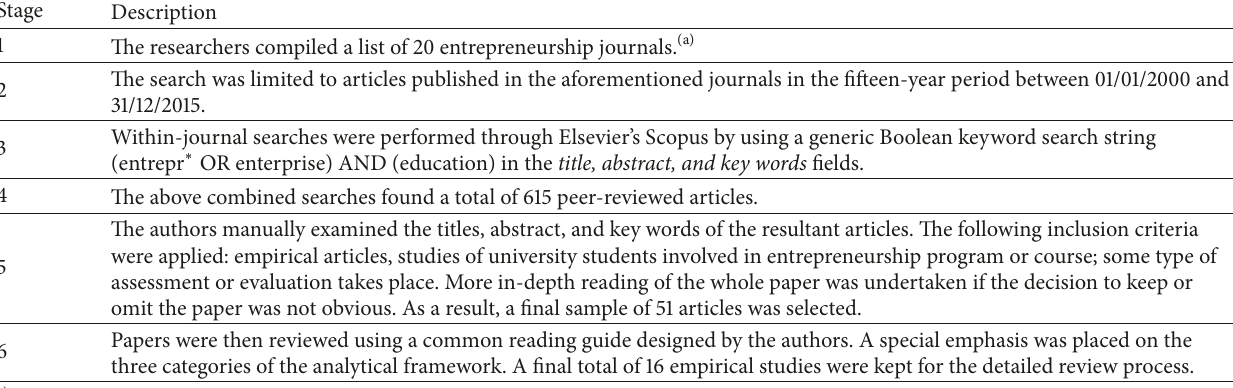
Table 3: Steps in the review process.